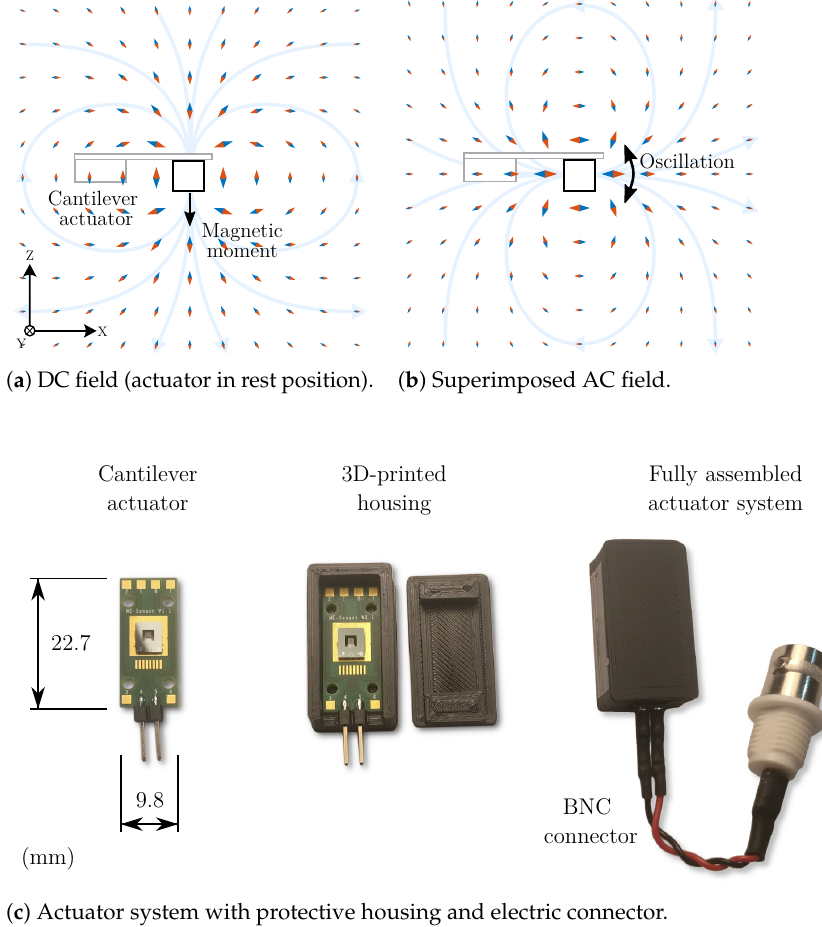
Figure 1. Overview of the principle and the physical setup of the cantilever actuator